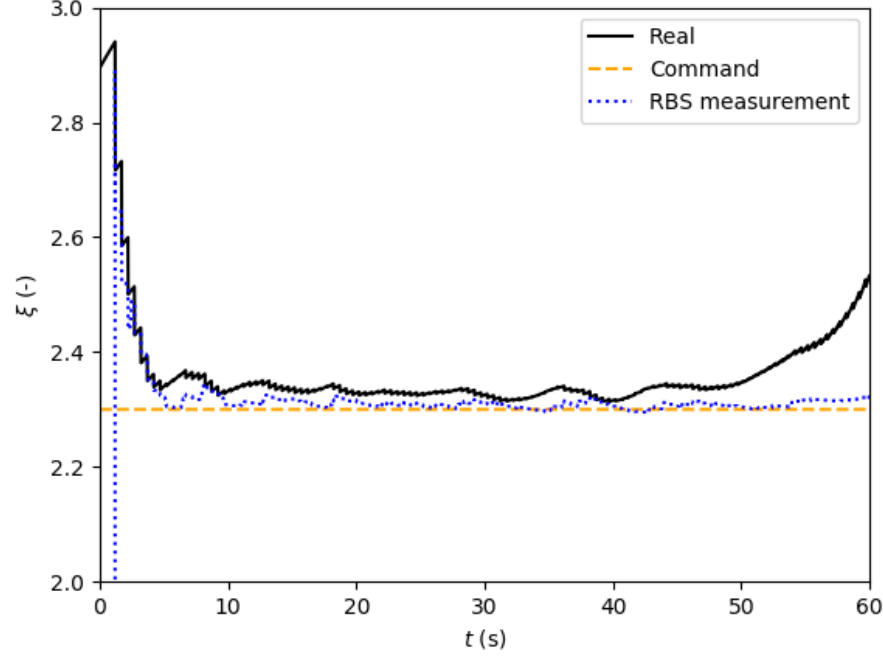
Figure 30. Mixture ratio profile, feedback with complete regulation law, case 3.